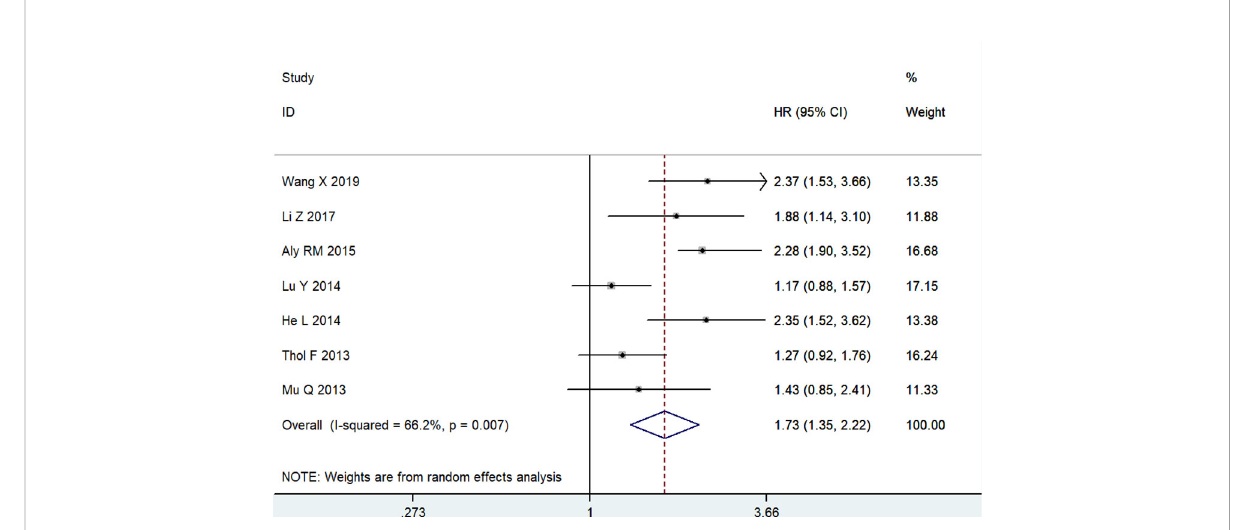
FIGURE 3 Forest plot of studies evaluating hazard ratios of high MSI2 expression and the disease-free survival of cancer patients.